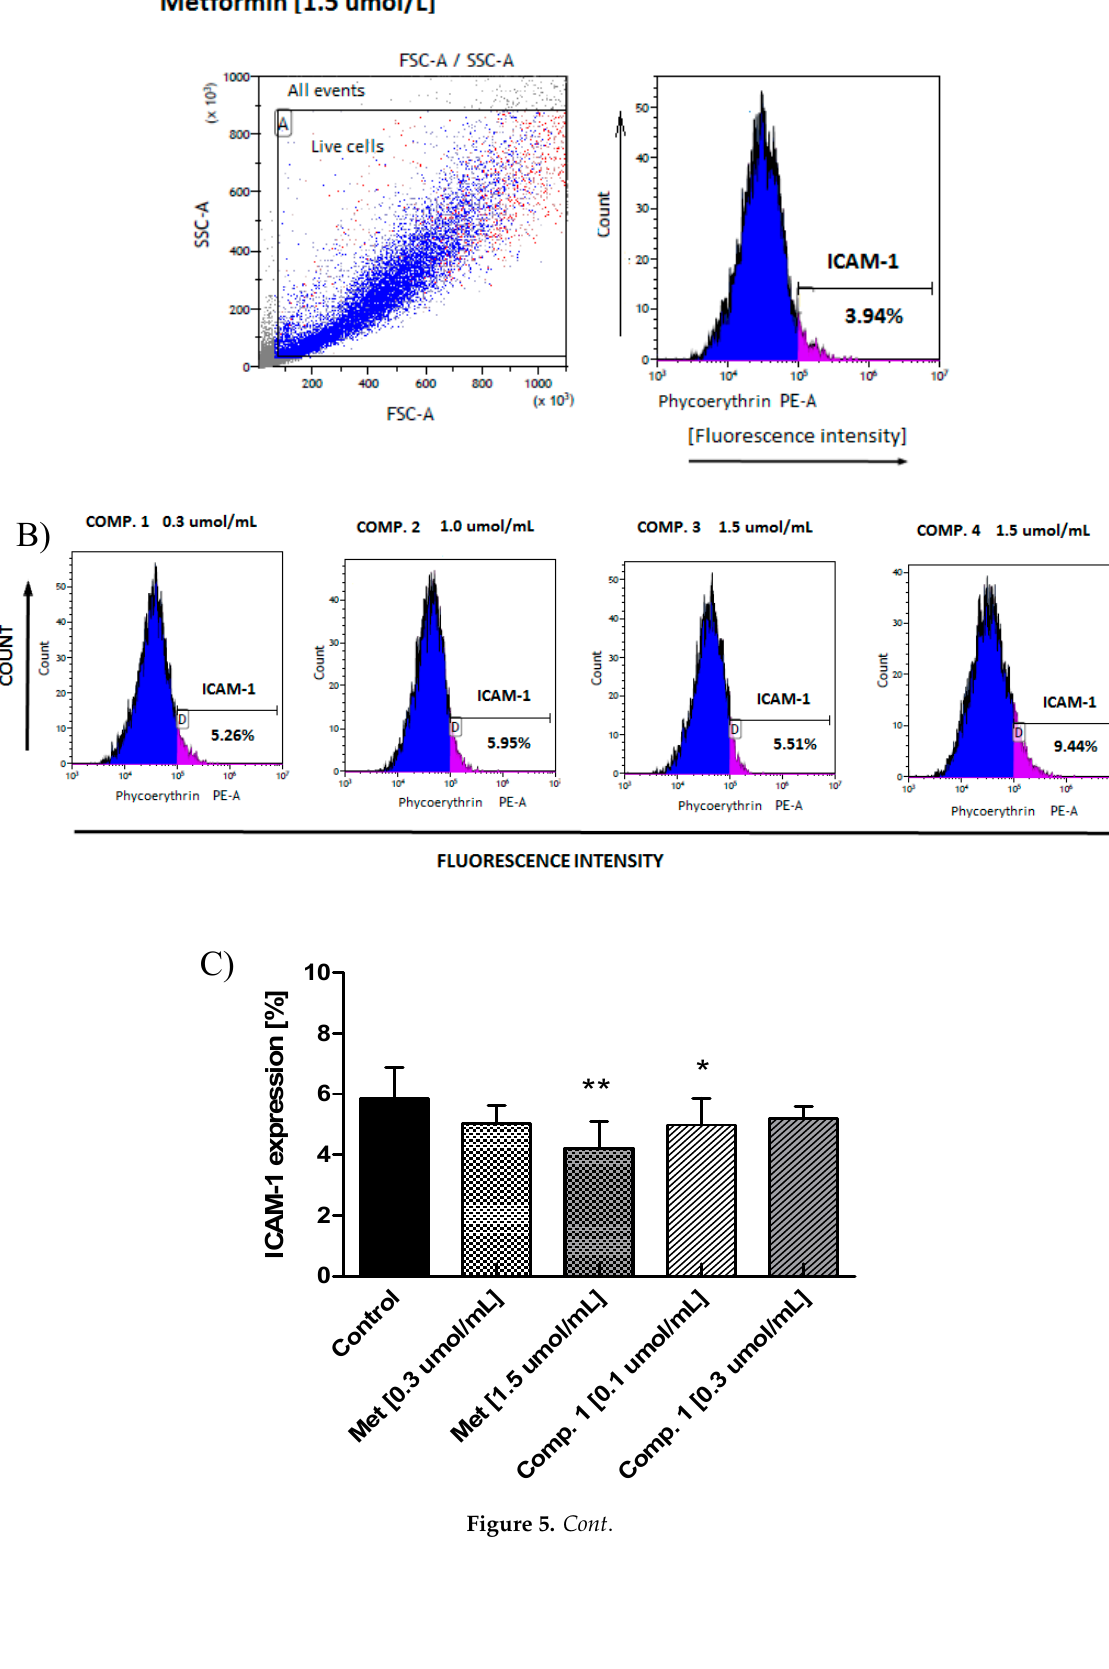
Figure 5. Cont Figure 5. Cont.